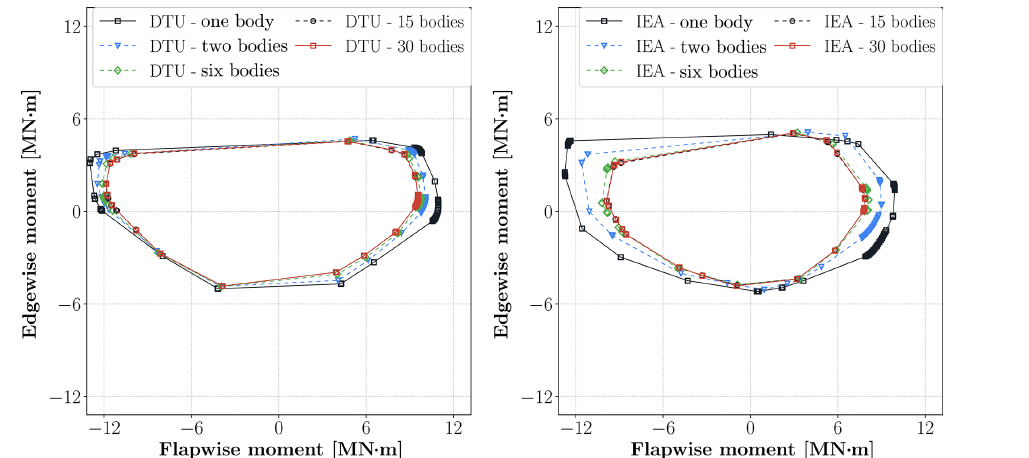
Figure 9. Cross-section flapwise and edgewise load envelopes at 43.6m blade radius of the DTU turbine and 51.1m blade radius of the IEA turbine for 1-, 2-, 6-, 15- and 30-sub-body cases.